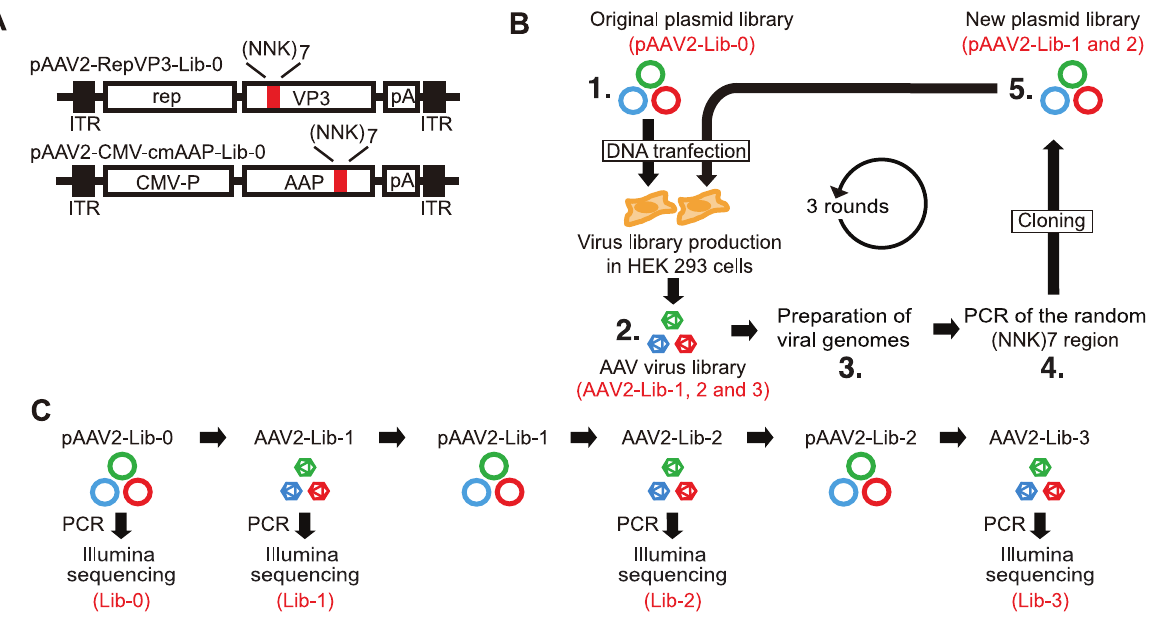
Figure 2. The approach used for the experimental directed evolution of the VP/AAP-overlapping ORFs. ( A ) Map of VP3 and AAP mutant plasmid libraries. Red bars indicate the random heptapeptide region corresponding to the QVKEVTQ/KSKRSRR motifs. ( B ) Schematic representation of the AAV directed evolution procedure. The numbers 1 through 5 in the figure indicate steps in the procedure. Step 1, Construction of the original plasmid DNA library (pAAV2-Lib-0); Step 2, Production of AAV virus library (AAV2-Lib-1); Step 3, Recovery of viral genomic DNA; Step 4, PCR amplification of the heptapeptide-coding region in the viral genome; Step 5, Construction of the next round plasmid DNA library using the PCR amplicons from Step 4 (pAAV2-Lib-1). Then Step 2 follows for the next round positive selection. This procedure was repeated three times to obtain AAV2-Lib-2 and AAV2-Lib-3. ( C ) The timeline of Illumina sequencing of PCR amplicons of the heptapeptide region. Illumina sequencing was used for extensively characterize the heptapeptides evolved by the experimental procedure.